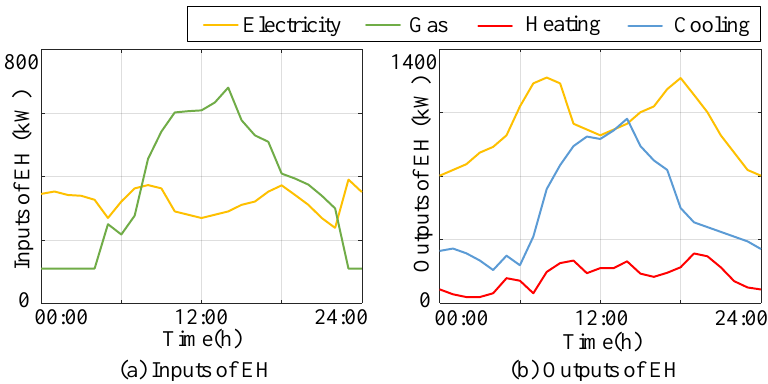
Figure A1. The electricity, heating and cooling loads for the EH in four seasons.